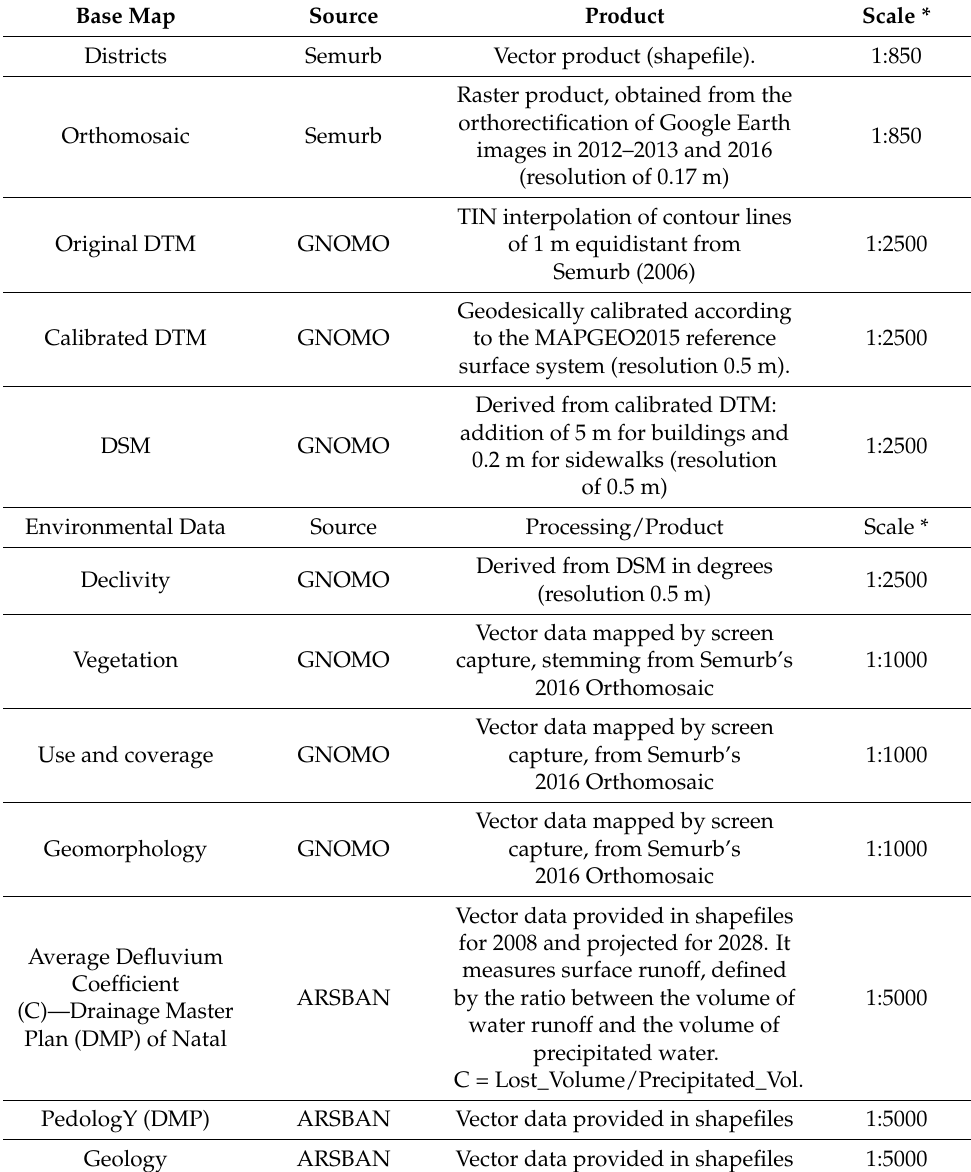
Table 1. Spatial layers used in the calculation of environmental vulnerability of landslides in the district of M ã e Luiza, Natal, RN. Base Map Source Product Scale * Districts Semurb Vector product (shapefile). 1:850 Orthomosaic Semurb Original DTM GNOMO Calibrated DTM GNOMO DSM GNOMO